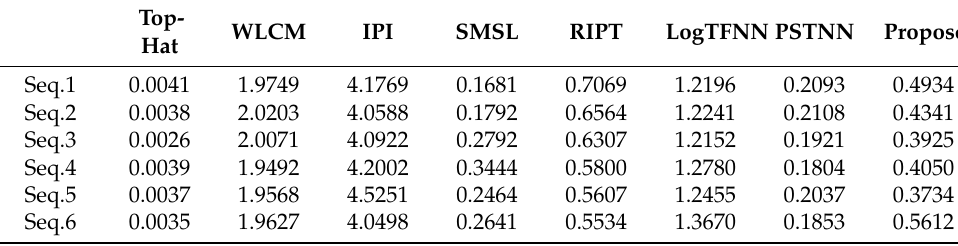
Table 5. The computing time of different methods for six sequences